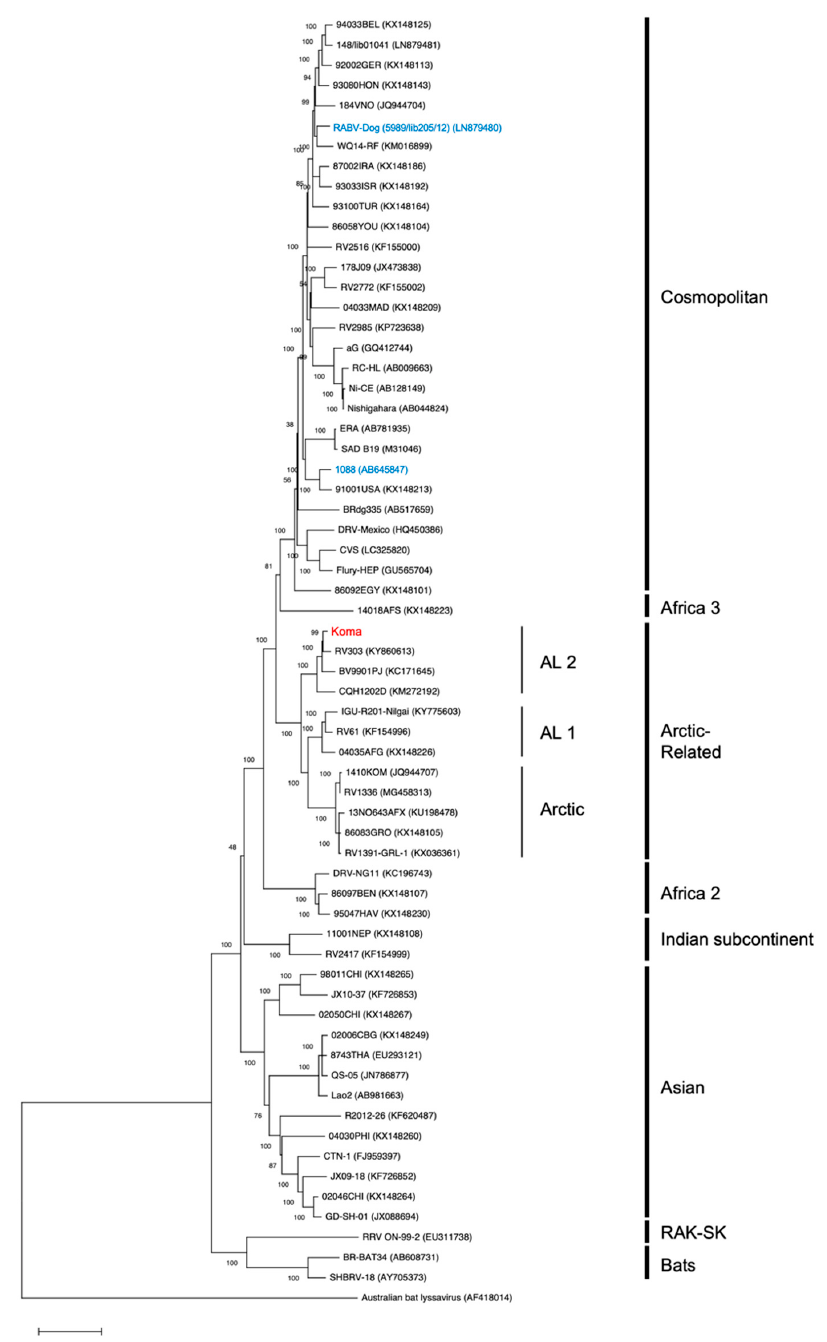
Figure 2. Phylogenetic relationships of the Koma strain with other rabies virus (RABV) strains. Complete genome nucleotide sequences of a total of 63 strains, which are representative strains of the major phylogenetic clades previously reported [31], were obtained from the GenBank database and were subject to phylogenetic analysis by the maximum ‐ likelihood method, together with the genome sequence of the Koma strain. The genetic analysis software Molecular Evolutionary Genetics Analysis (MEGA) version 10.1 was used for phylogenetic analysis. Numbers at nodes and in parentheses represent bootstrap values obtained from 1000 replicates and the accession numbers in the GenBank database. The bar indicates 0.10 substitutions per nucleotide position. The Koma strain and two street strains (1088 and RABV ‐ Dog) are shown in red and blue, respectively.